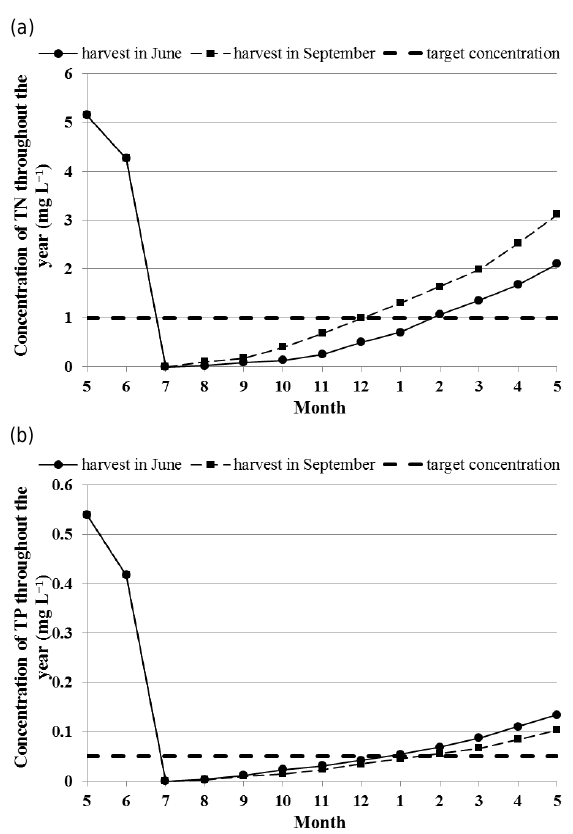
Fig 2. Lake water quality throughout the year under different harvest schemes 4 Figure 2. Lake water quality throughout the year under different harvest